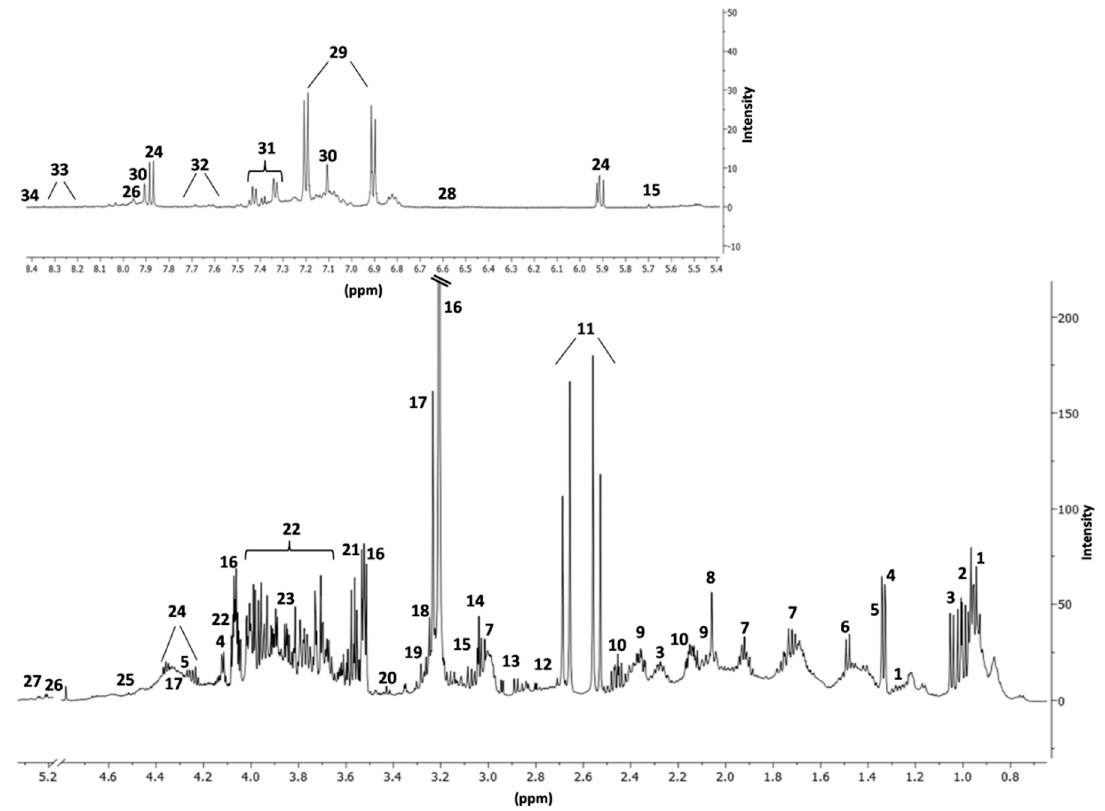
Figure 1. Identified compounds in a control sample seminal fluid NMR spectrum. * = uncertain